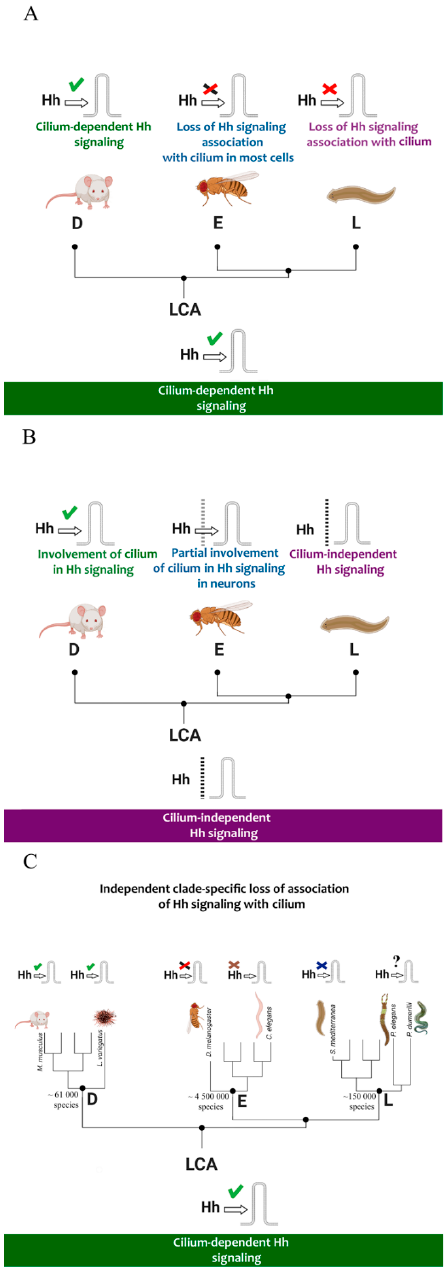
Figure 12. Three possible scenarios for the integration of Hh signaling transduction within the primary cilium in three bilaterian branches: Ecdysozoa, Lophotrochozoa, and Deuterostomia. ( A ) According to the first scenario, cilium-dependent Hh signaling emerged at the level of the last common ancestor of most bilaterian animals (LCA). In the Deuterostomia (D) lineage, this condition was retained, whereas in the Ecdysozoa (E) lineage, the Hh pathway’s association with the cilium was preserved only in particular cell types. In the Lophotrochozoa (L) lineage, this association was lost. ( B ) The second scenario assumes a cilium-independent Hh pathway in the LCA. In this case, D and E independently linked Hh signaling to the cilium. ( C ) In the third scenario, cilium-dependent Hh signaling existed initially, but its high evolutionary lability at the level of intracellular messengers does not allow generalizable conclusions to be drawn for large taxa (D, E, L). Single model animals from a huge number of Ecdysozoa and Lophotrochozoa species could have independently lost their connection between Hh and the cilium at different stages of signal transduction, but this does not reflect the state of the Hh pathway in the Protostomia